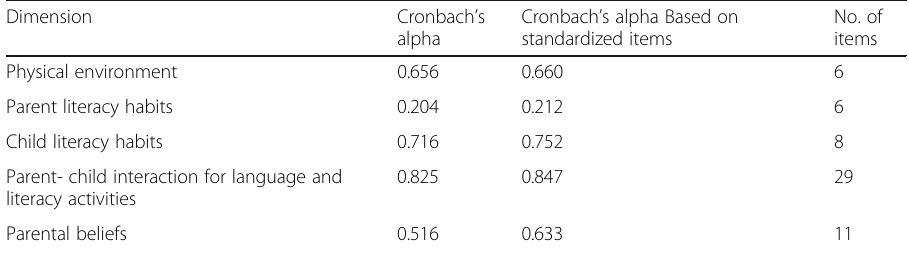
Table 7 Cronbach ’ s alpha for the five dimensions